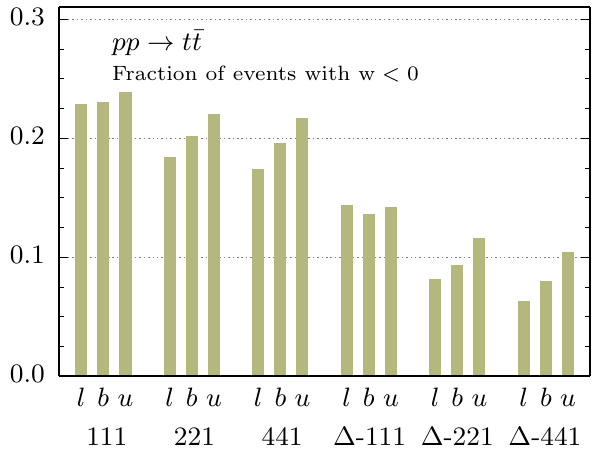
Figure 11 . Fractions of negative-weight events, in t (cid:22) t